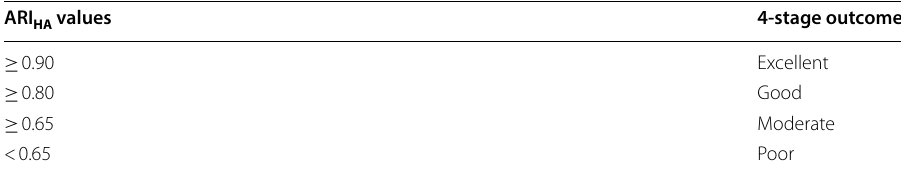
Table 1 Set of Heuristics for validating clustering technique ARI HA values 4-stage outcome ≥